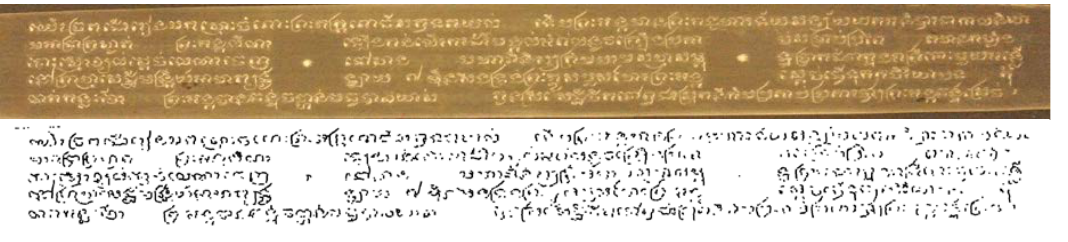
Figure 21. Binarization of Khmer manuscript with ICFHR G1 method.